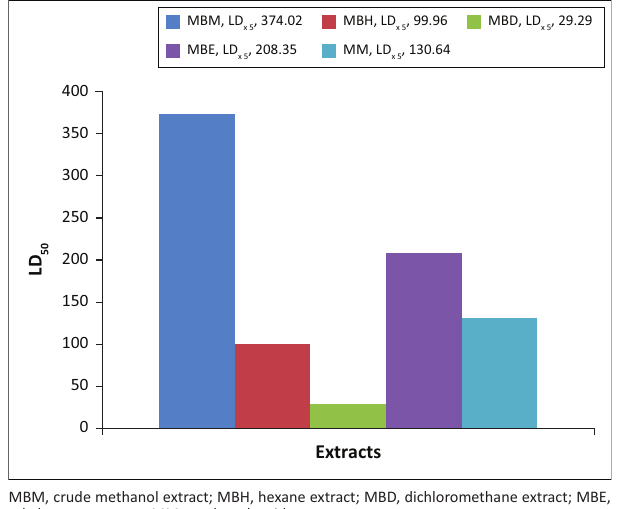
values) of the extracts of Mezoneuron 50